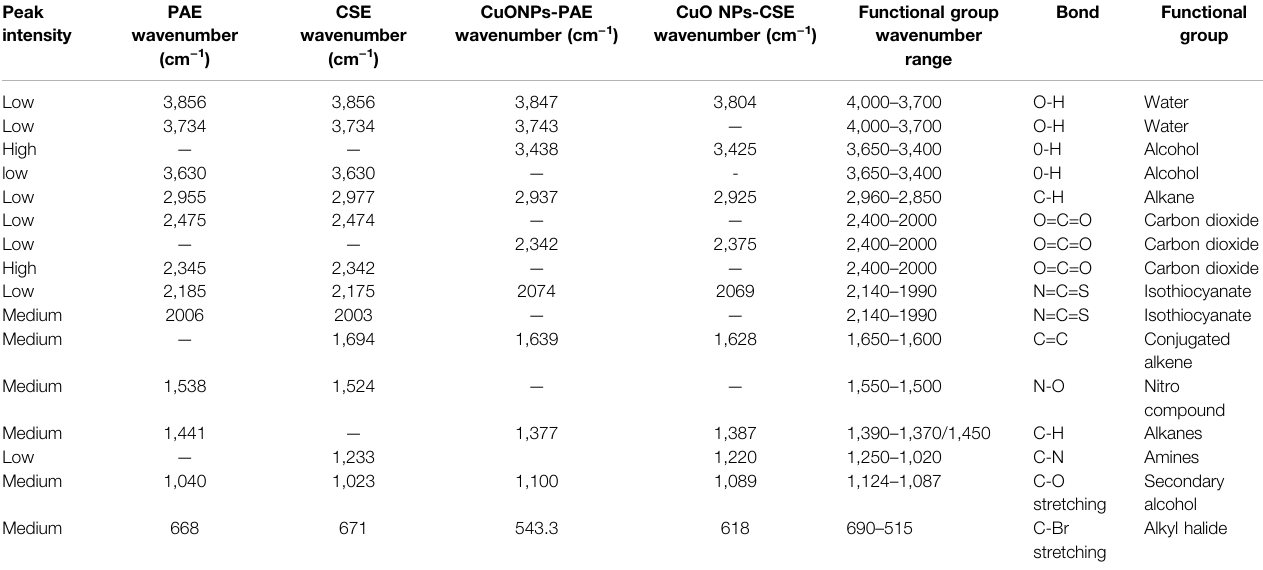
TABLE 2 | PAE and CSE phytochemical functional groups encapsulation CuONPs. Peak